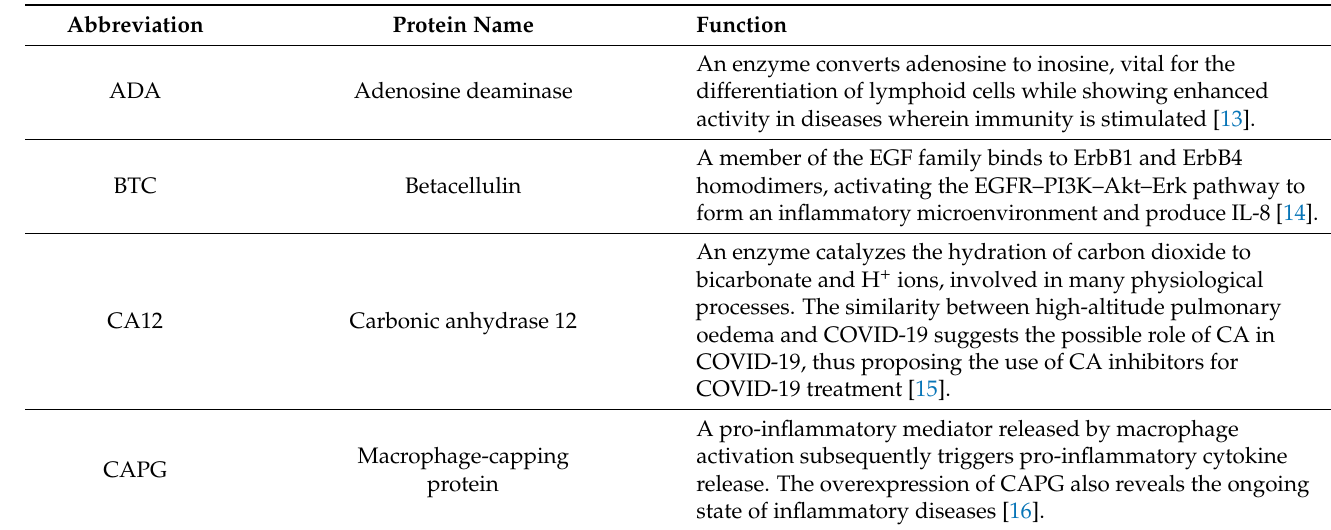
Table 1. A list of the markers showed significant upregulation in COVID-19 deceased